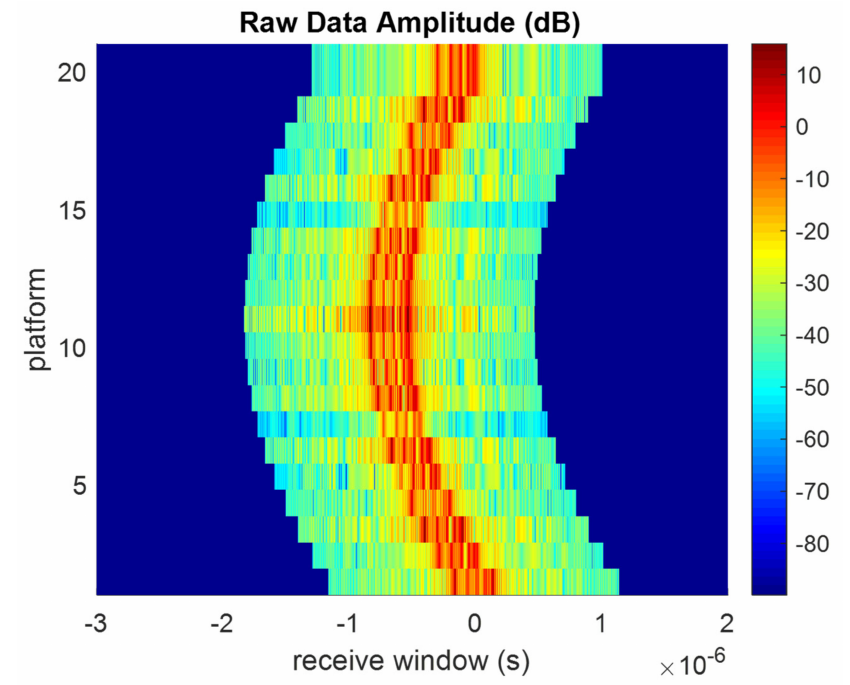
Figure 20. An example 2D simulation result showing raw data